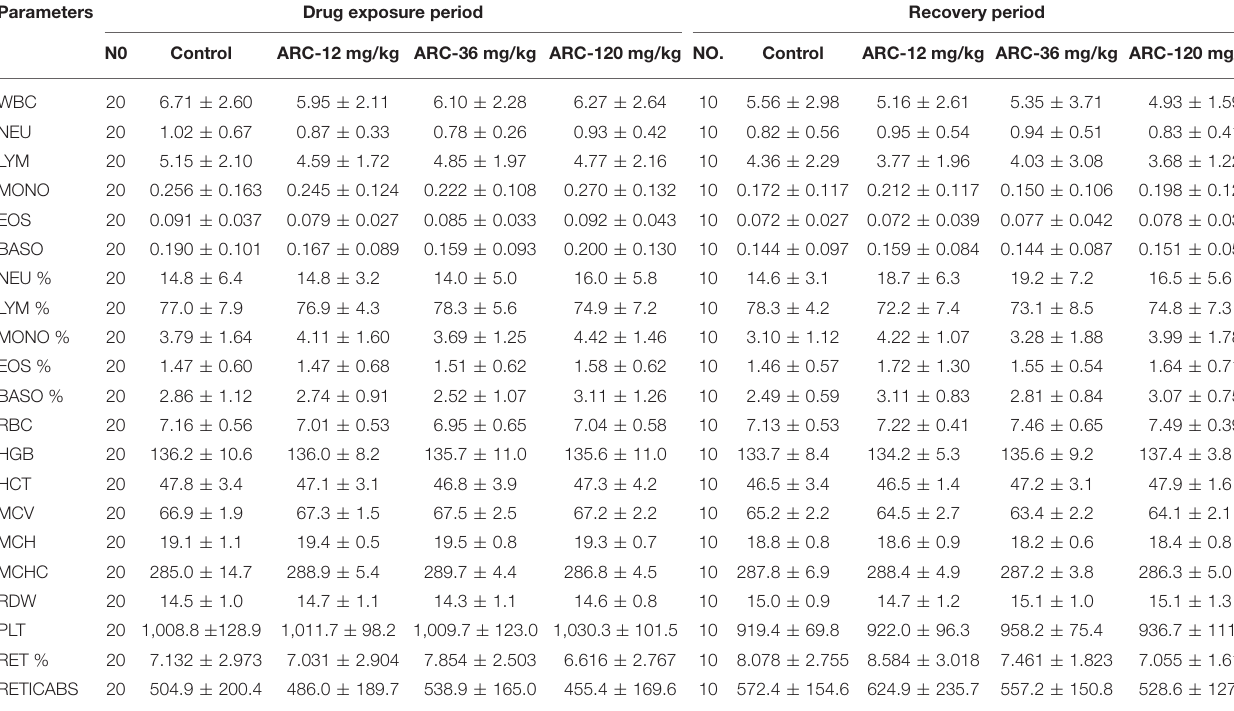
TABLE 2 | The hematologic examination paremeters of Arctigenin (12-, 36-, and 120 mg/kg) administration by gavage (i.g) in rats’ serum at the end of drug exposure period ( n = 30, 15 female, 15 male) and recovery period ( n = 10, 5 female, 5 male per treatment group, results were presented as Mean ± SD). Parameters